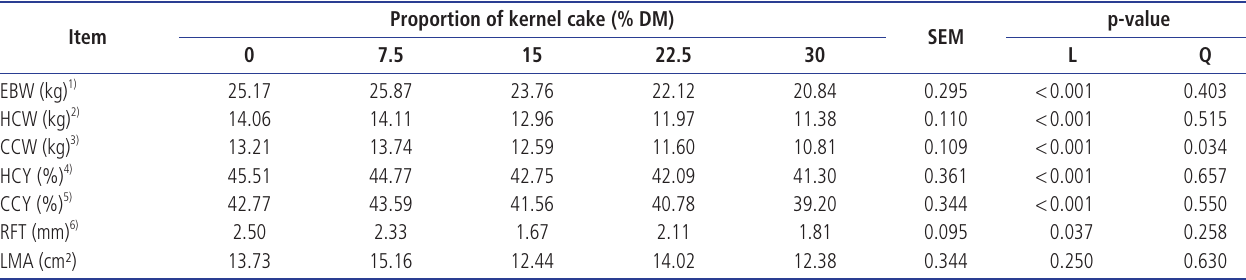
Table 2. Carcass characteristics from lambs fed diet with palm kernel cake